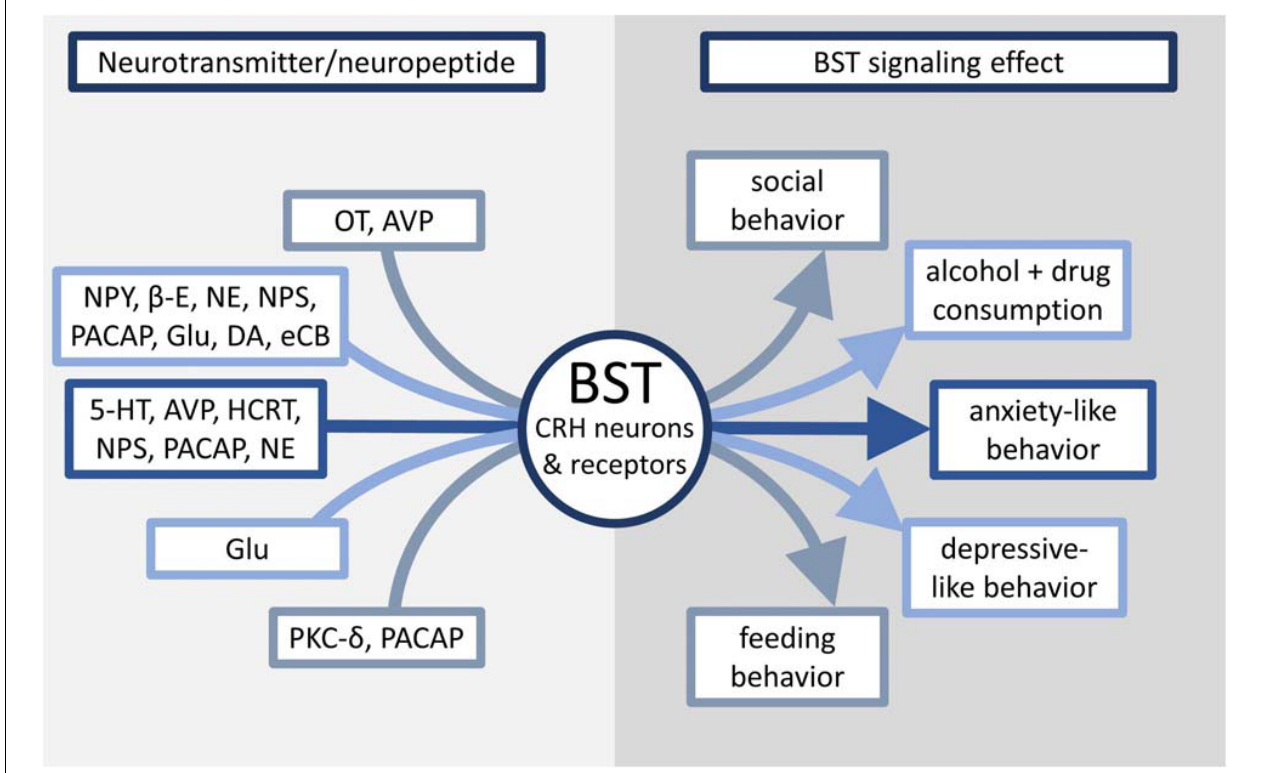
FIGURE 1 | Overview of neurotransmitters linked to CRH signaling in the BST and their effects on maladaptive